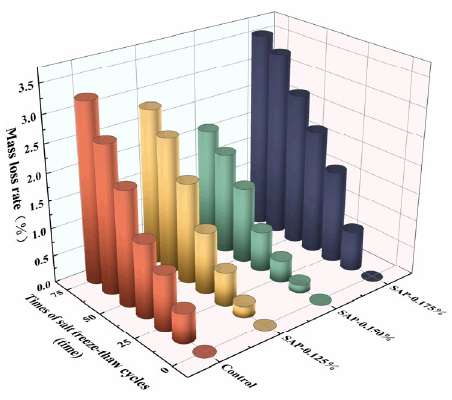
Figure 3. Mass loss rate of pavement concretes with different times of salt freeze–thaw cycles.